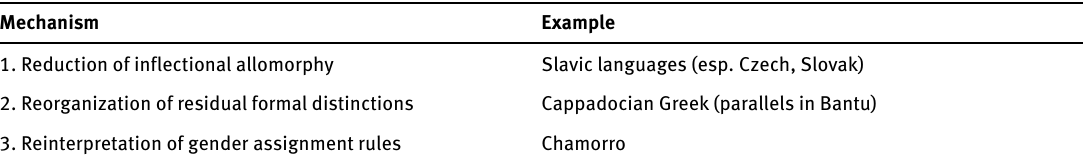
Table 12. Effects of animacy and natural gender on morphological